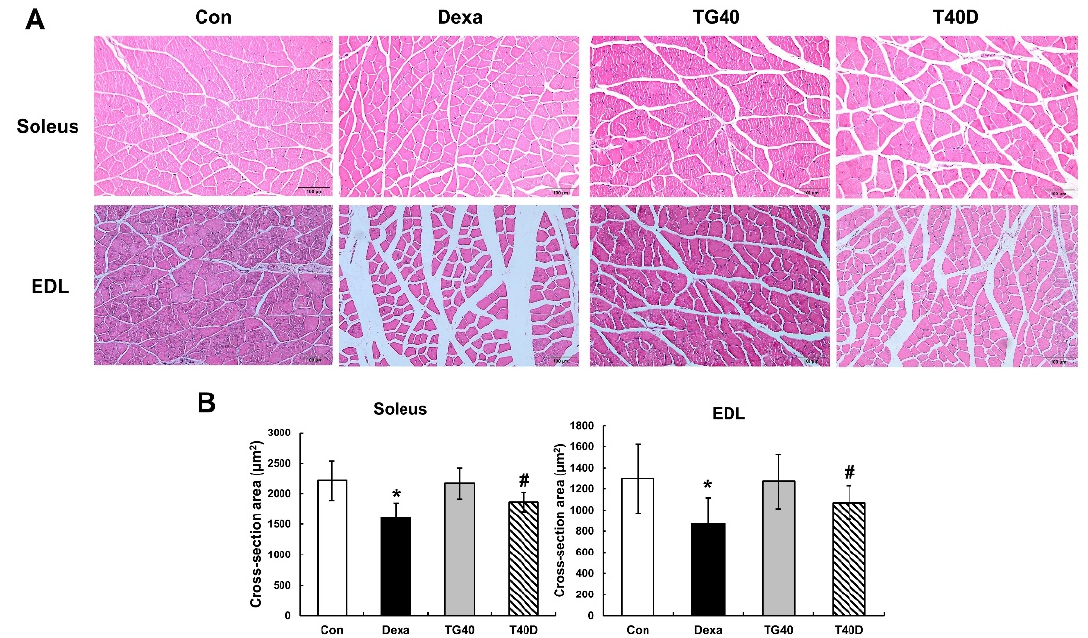
Figure 3. Effects of teaghrelin on muscle cross-sectional area (CSA) in Dexa-treated rats. At the end of the experiment, the soleus and extensor digitorum longus (EDL) muscles were collected. Skeletal muscle sections of the soleus and EDL were stained (hematoxylin and eosin) and observed by light microscopy (400×). Scale bar: 200 μ m ( A ) . The CSA of the soleus and EDL were calculated by im- ageJ software ( B ). The Con, Dexa, TG40 and T40D groups are defined in Figure 1. The results were analyzed using one-way ANOVA. Values are presented as the mean ± SD (n = 5 or 6). * p < 0.05 versus Con; # p < 0.05 versus Dexa.